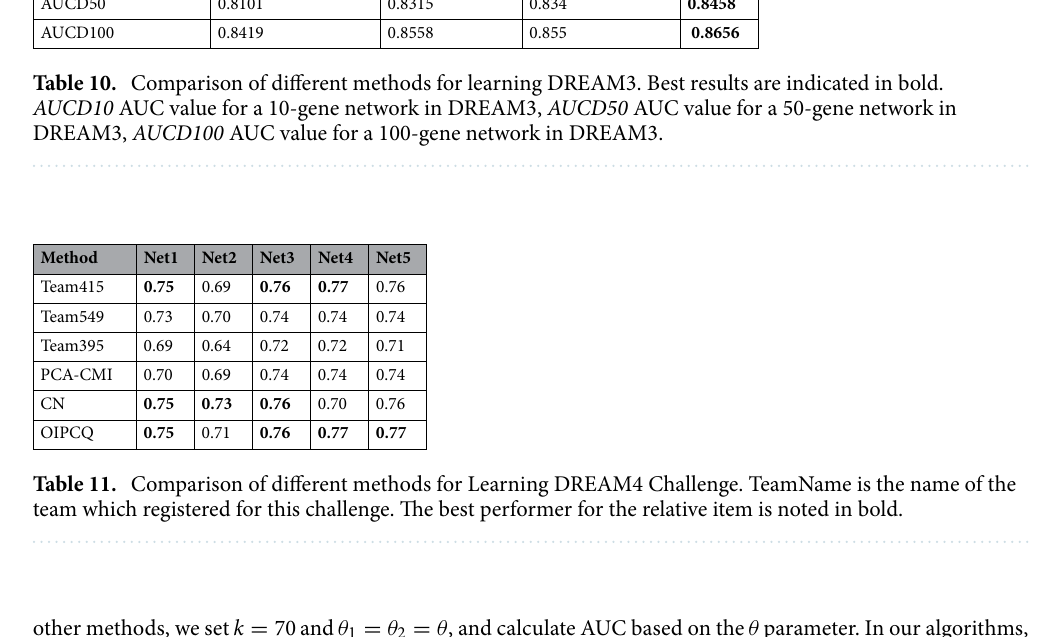
algorithm is compared with that of PCA-CMI, CN and three best teams which participated on this challenge in http:// wiki. c2b2. colum bia. edu/ dream/ resul ts/ DREAM4/. From Table 11, we can find that the proposed method (OIPCQ) performs as good as the best method in DREAM4 challenge. In Networks 1,3 and 4, the results of the OIPCQ algorithm are similar to the best team (TEAM415). In Network 5, our algorithm has the best performance and in Networks 2, the CN algorithm among the challenge participants has the best result.